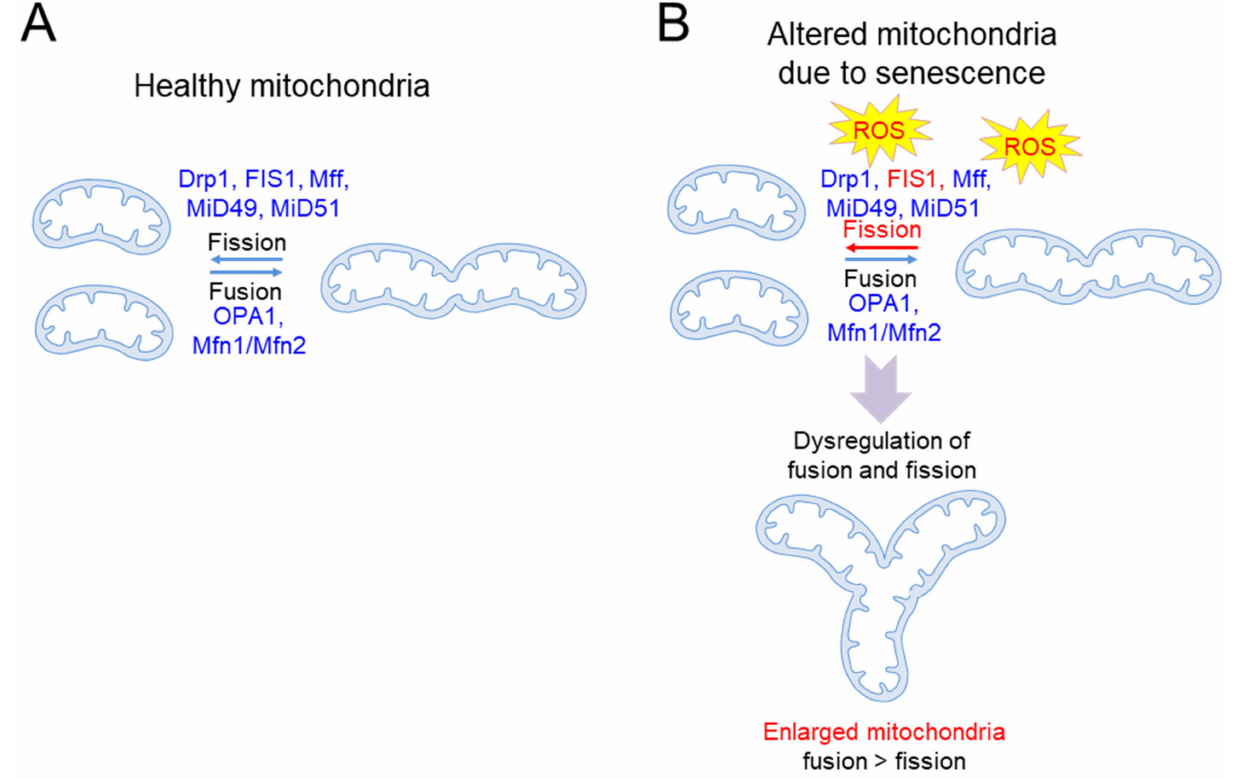
Figure 1. Schematic representation of basic mechanisms of senescence-induced mitochondrial damage. ( A ) Mitochondria are organelles that undergo a continuous cycle of fusion and division. The proteins involved in mitochondrial fusion include mitofusin 1 (Mfn1), mitofusin 2 (Mfn2), and mitochondrial dynamin-like GTPase (OPA1). Proteins involved in mitochondrial fission include fission 1 protein (FIS1), mitochondrial fission factor (Mff), mitochondrial dynamics proteins of 49 kDa and 51 kDa (MiD49 and MiD51, respectively), and dynamin-related protein 1 (Drp1). ( B ) As senescence progresses, dysfunctional mitochondria are not efficiently eliminated and constitute a major cause of excessive ROS production. Increased oxidative damage by senescence depletes FIS1 and disrupts the mitochondrial fusion/fission balance, resulting in the formation of enlarged mitochondria. ROS: reactive oxygen